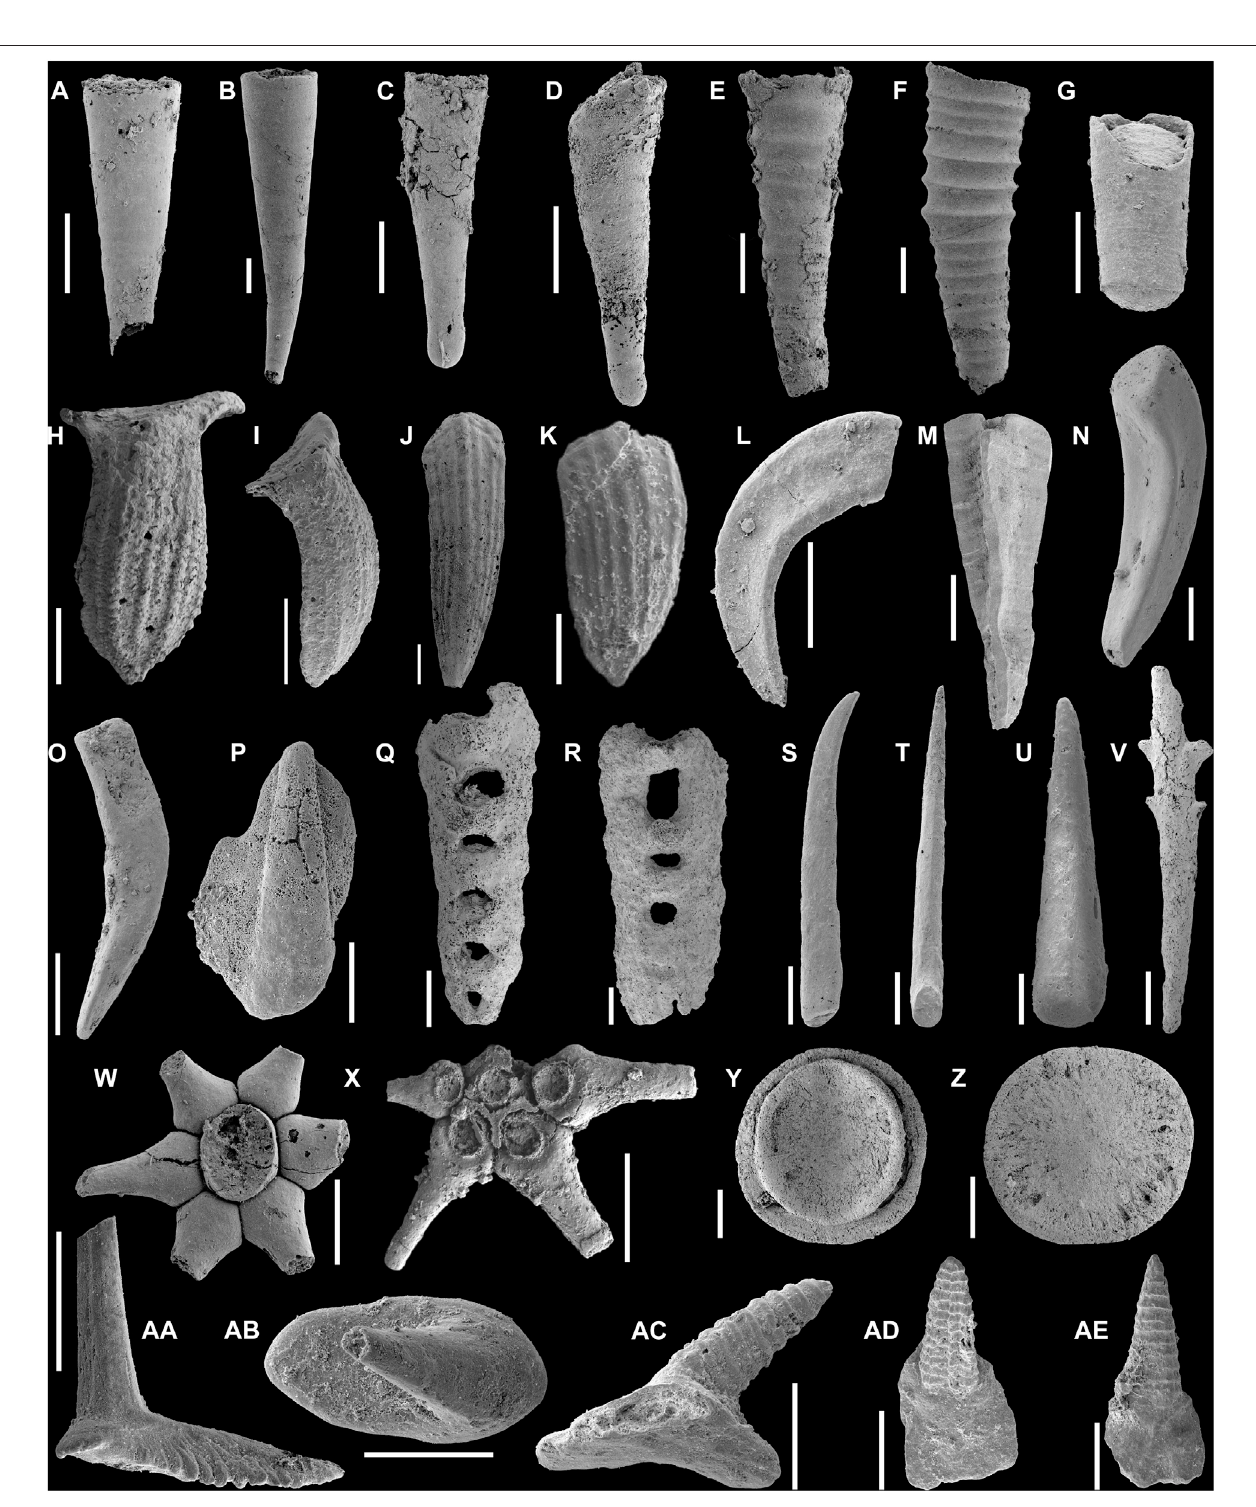
FIGURE 3 | Small shelly fossils from the upper Maidiping Formation at the Fandian section. (A,B) Conotheca subcurvata (Yu, 1974); (A) NIGPAS 180248, LSF- 13.5m, lateral view; (B) NIGPAS 180249, LSF-13.5m, lateral view. (C,D) Paragloborilus subglobosus Qian, 1977; (C) NIGPAS 180250, LSF-13.5m, lateral view; (D) NIGPAS 180251, LSF-17m, lateral view. (E,F) Annelitellus yangtzensis Qian, 1989; (E) NIGPAS 180252, LSF-13m, lateral view; (F) NIGPAS 180253, LSF-13m, lateral view. (G) Cupitheca mira He in Qian, 1977, NIGPAS 180254, LSF-18m, lateral view. (H – K) Halkieria sacciformis Meshkova, 1969; (H) , NIGPAS 180255, LSF- 12.1m, upper surface; (I) .NIGPAS 180256, LSF-18m, lateral upper side; (J) NIGPAS 180257, LSF-13.5m, upper surface; (K) NIGPAS 180258, LSF-13m, upper